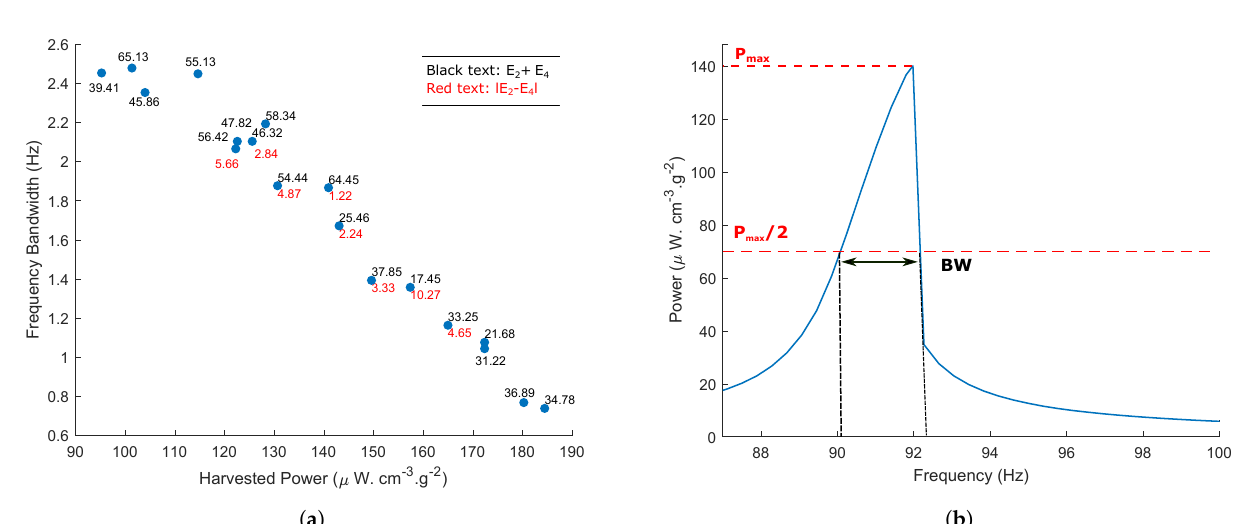
Figure 8. ( a ) 2D projection of the Pareto front. ( b ) Harvested power of the optimal configuration. The simultaneous functionalization of the nonlinearity, the energy localization phe- nomenon and the multimodal configuration show an improvement up to 101% of the harvested power and 79% of the frequency bandwidth compared to the performances given by the 2-DOFs nonlinear system with perturbing only one DOF. The 5-DOFs periodic system is also studied in order to compare its performance to the one of the optimized quasiperiodic 5-DOFs system. In this case, the power is harvested from all the vibrating P n ) . Following the same strategy, the Pareto front of the 5-DOFs oscillators ( P = ∑ 5 n = 1 periodic system maximizing the harvested power is plotted in Figure 9. The optimal pa- rameters that maximize simultaneously the harvested power and the frequency bandwidth for the periodic 5-DOFs system are β = 1.1%, R load = 22 Ω . The obtained results show that the proposed quasiperiodic model provides a larger bandwidth and comparable har- vested power compared to the periodic one. In fact, the difference between the harvested powers in the two cases is of 6.15% and the frequency bandwidth is higher by 18% in the periodic system.